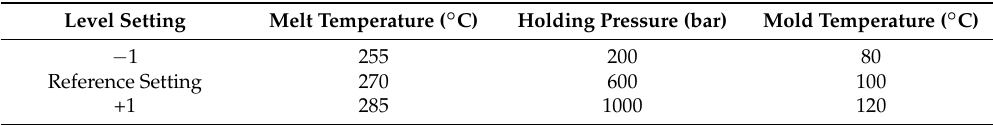
Table 8. Level settings for the low, the reference and the high level